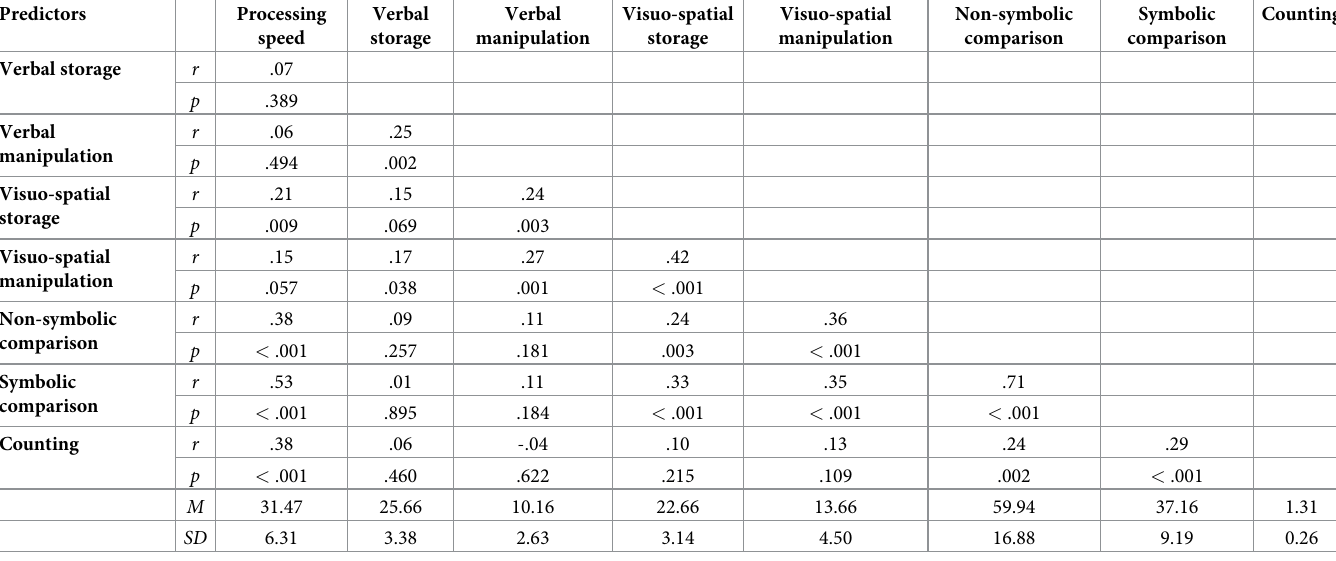
Table 2. Descriptive statistics and correlations between predictors of order processing at